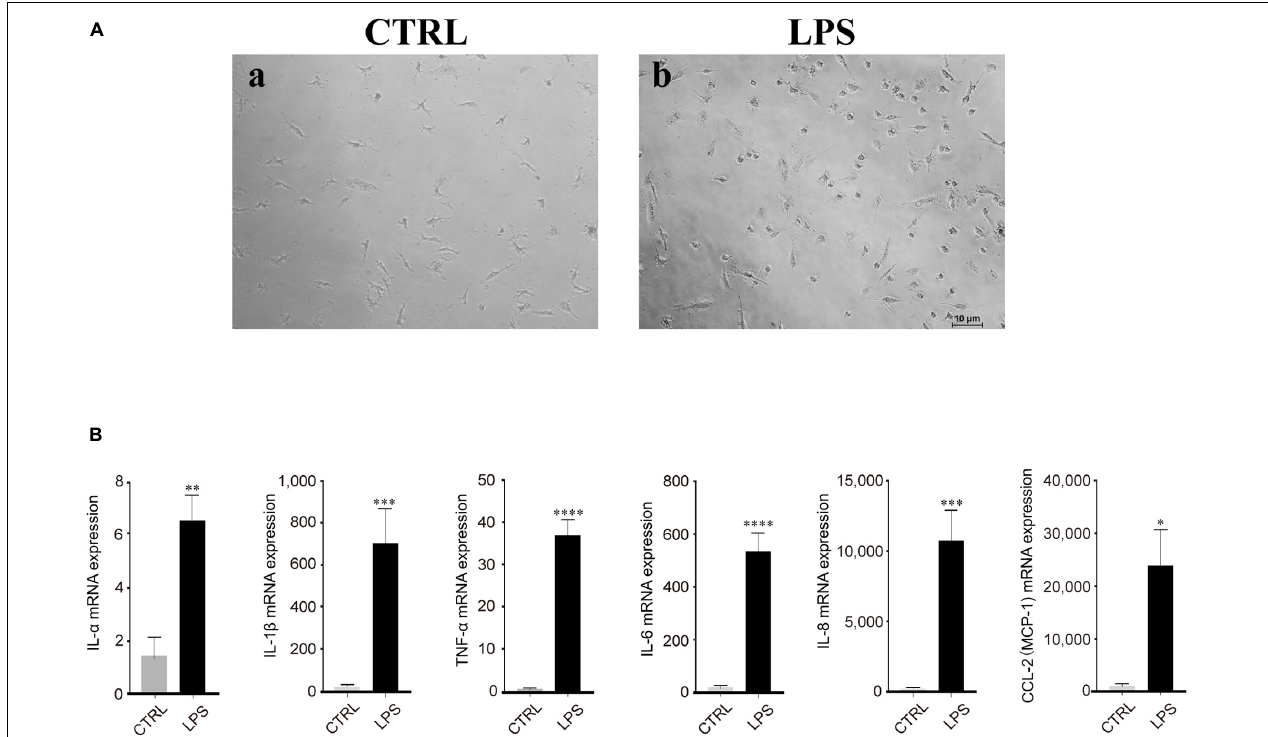
FIGURE 4 | Lipopolysaccharide (LPS)-induced retinal microglia exhibited proinflammatory reactions. (A) Representative images of retinal microglia under 24 h LPS (100 ng/ml) stimulation manifested as morphological changes from the original polarized shape to an ameboid-like shape (Blue: rounded; yellow: ameboid; red: ramified; scale bar: 100 µ m). (B) LPS stimulated retinal microglia showed significant mRNA expression of IL-1 α / β , IL-6, IL-8, MCP-1/CCL-2, and TNF- α by qRT-PCR. Data were analyzed using an unpaired t -test. These assays were repeated three times. All data were normally distributed. ∗ P < 0.05, ∗∗ P < 0.01, ∗∗∗ P < 0.001, and ∗∗∗∗ P <